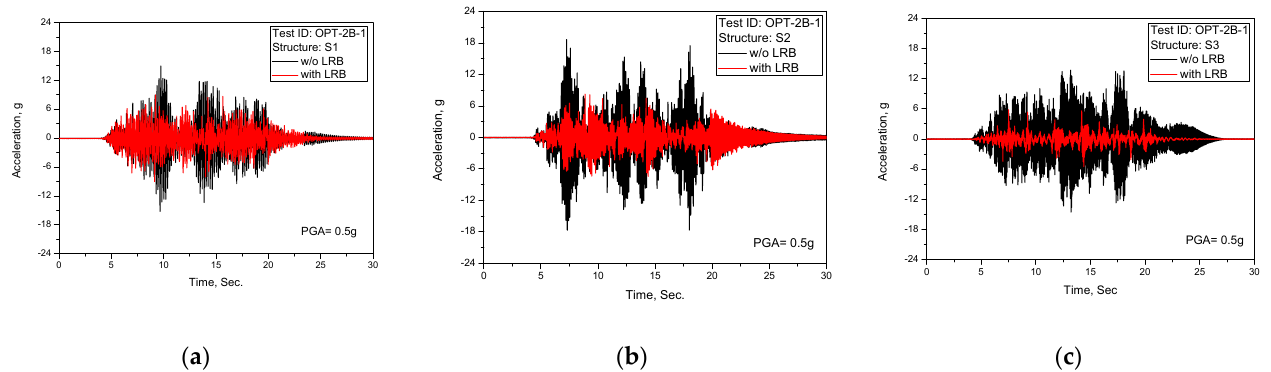
Figure 9. Test results of acceleration time history response (TEST ID: OPT-2B-1, PGA = 0.5 g): ( a ) S1; ( b ) S2; ( c ) S3.